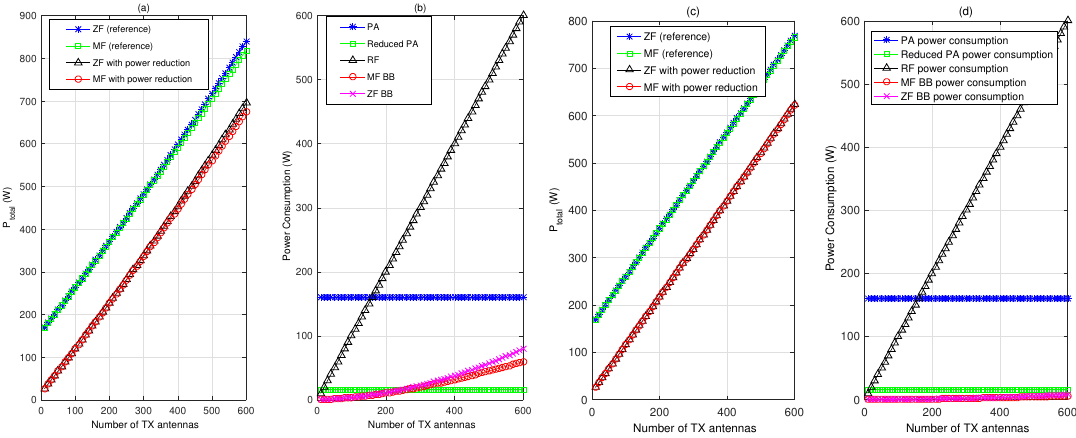
Figure 8. ( a ) total power consumption; and ( b ) power consumption of each component, when (cid:36) = 5 Gflop/W, P RF = 1 W, P PA = 40 W and 4 W, K = 0.1 N t ; ( c ) total power consumption; and ( d ) power consumption of each component, when (cid:36) = 50 Gflop/W, P RF = 1 W, P PA = 40 W and 4 W, K = 0.1 N t